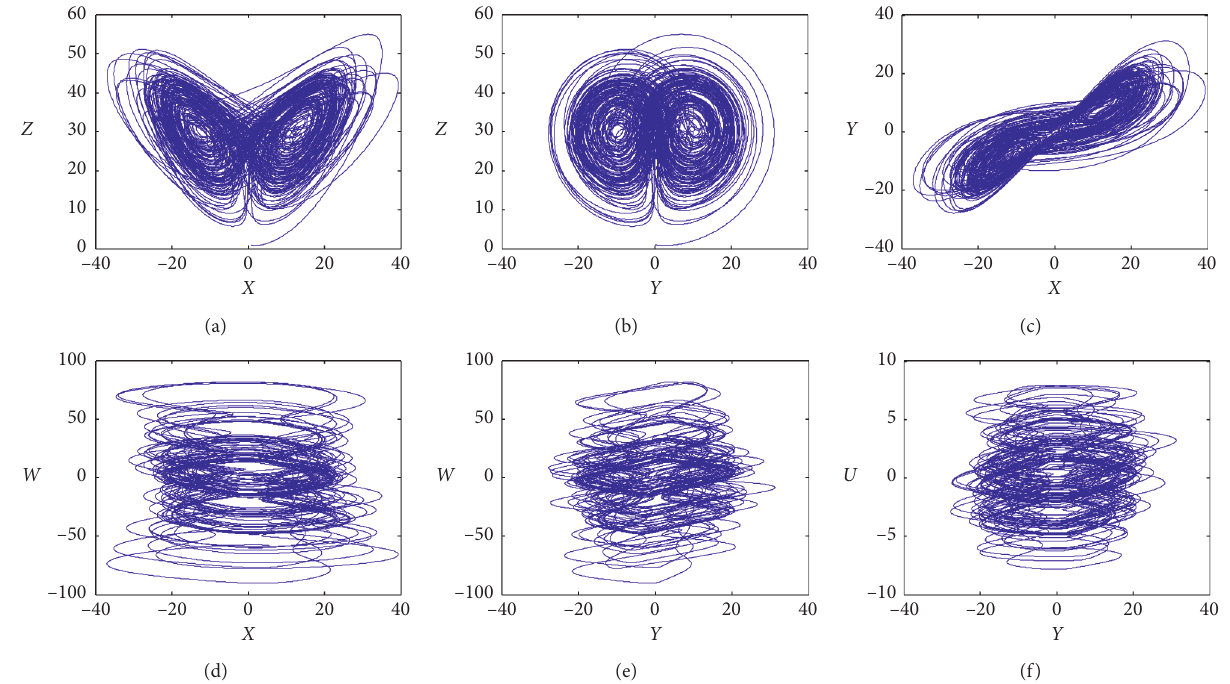
Figure 1: Different perspectives on the hyperchaotic attractor of system (3) without equilibrium.